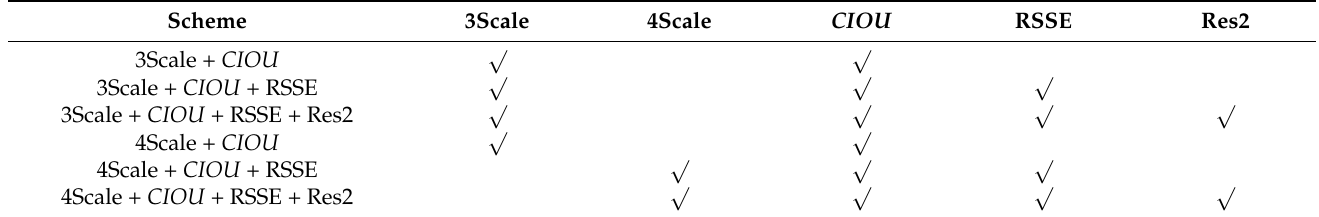
√ ” indicates the selected module.